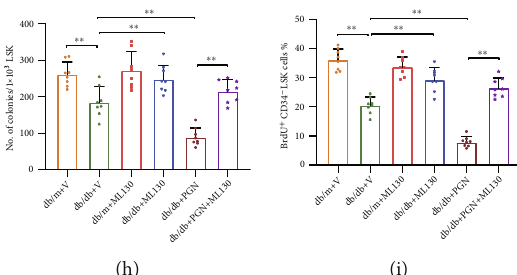
Figure 5: A NOD1-speci fi c inhibitor ameliorated PGN-mediated neurodegeneration in the bone marrow of diabetic mice and ultimately restored HSPC numbers and functions. (a) The upper images show representative tyrosine hydroxylase IHC staining of the femurs of mice from each group. The bottom quantitative data show that ML130, a speci fi c inhibitor of NOD1, restored the number of try-OH + nerve fi bers in the bone marrow of PGN-treated db/db mice ( n = 16 − 19 per group). (b) The upper images show representative NF200 IHC staining of mouse femurs. The bottom quantitative data show that ML130 protected against the PGN-induced degeneration of NF200 + neurons in the bone marrow of db/db mice ( n = 13 − 14 per group). (c) Representative images of HSPC subpopulations (LSK, LT-HSC, and ST-HSC) analyzed by fl ow cytometry. (d – f) ML-130 ameliorated the PGN-mediated depletion of bone marrow (e) LT- HSCs in diabetic mice. No changes in the percentages of the (d) LSK and (f) ST-HSC populations were observed among the groups ( n = 11 − 15 per group). (g) CFU assay shows ML130 ameliorated the increase in the number of BM CFU-G/M/GM and the decrease in the number of total CFUs in the blood induced by PGN in diabetic mice ( n = 12 per group). (h) 1 × 10 3 LSK cells from each group were cultured and tested for colonies in the LTC-IC assay ( n = 8 per group). (i) For the in vivo BrdU incorporation study, the percentages of LT-LSK cells in each group were analyzed by FACS ( n = 8 per group). Data represent mean ± SD . PGN: peptidoglycan; V: vehicle; LSK: Lin - /CD127 - /Sca-1 + c-Kit + ; LT-HSC: long-term repopulating hematopoietic stem cell; ST-HSC: short-term repopulating hematopoietic stem cell. ∗ P < 0 : 05 , ∗∗ P < 0 : 01 ; & compared to db/m+V; # compared to db/db+PGN; § compared to